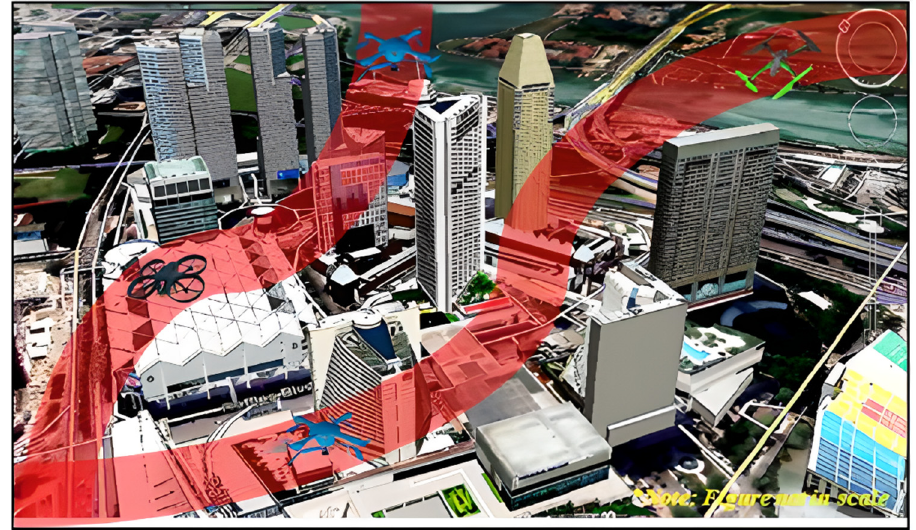
Figure 2. A city skyline with designated drone lanes (Pathiyil et al. 2016).